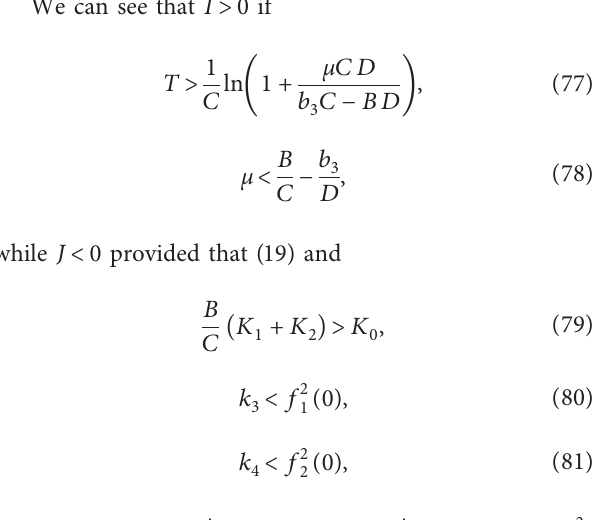
Figure 1: A computer simulation of systems (5) and (6). The solution trajectory approaches oscillatory solution ( 0 , 􏽥 w ( t )) when time passes. � 0 . 32 ,a � 0 . 58 ,a � 0 . 19 ,a � 0 . 39 ,a � 0 . 1, a � 0 . 34 ,a � 0 . 91 ,a � 0 . 7 ,a � 0 . 03, b Here, a 1 2 3 4 5 6 7 8 9 � 0 . 15 ,k � 0 . 56 , k � 0 . 95, k � 0 . 96 ,k � 0 . 99 ,k � 0 . 84 ,k � 0 . 65, μ � 0 . 01 , ρ � 0 . 2 ,T � 1 , z ( 0 ) � 0 . 1, and w ( 0 ) � 0 . 1 in which all 1 2 3 4 5 6 conditions in Theorem 1 are